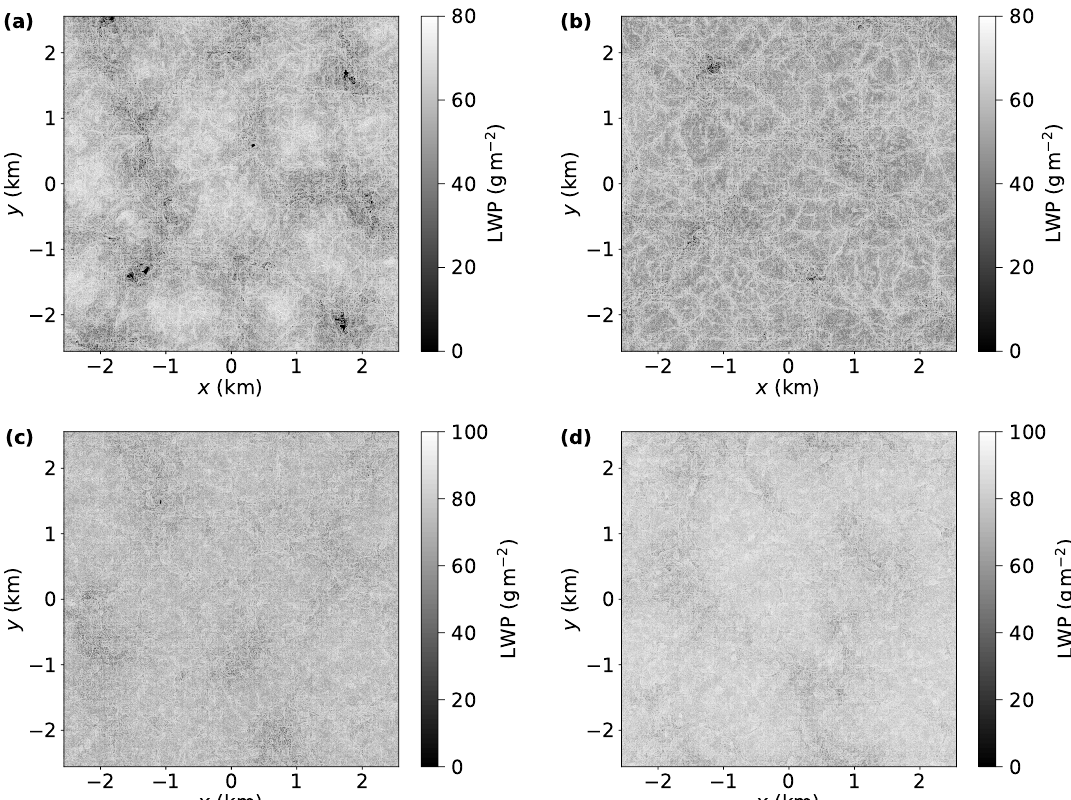
Figure 4. Liquid water path for the runs without surface fluxes (only driven by radiation). Top panels ( a , b ) include the effects of evaporative cooling. Bottom panels ( c , d ) correspond to the run without evaporative cooling. Left column panels ( a , c ) correspond to t = 2 h and right column panels ( b , d ) to t = 4